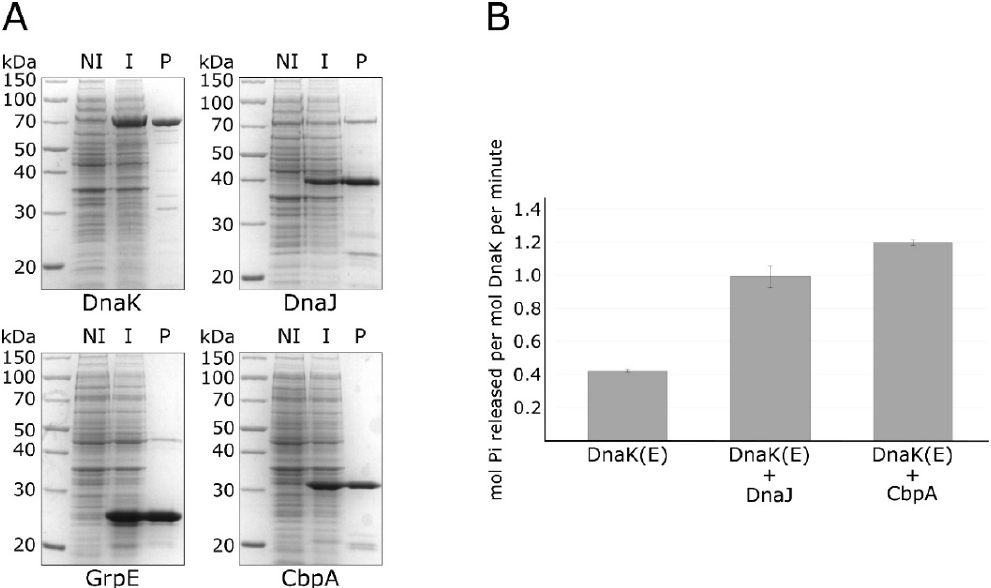
Figure 2. Purification of recombinant chaperone proteins and in vitro ATPase assay. Panel ( A ) sodium dodecyl sulfate–polyacrylamide gel electrophoresis (SDS-PAGE) showing the DnaK, DnaJ, GrpE and CbpA purified proteins (marked underneath each panel) following Ni–NTA affinity chromatography. Symbols: NI, total protein extract of non-induced bacteria; I, total protein extract from induced bacteria; P, purified protein. Panel ( B ) ATPase activity of DnaK measured alone (DnaK (E)), with DnaJ (DnaK (E) + DnaJ) or with CbpA (DnaK (E) + CbpA). Standard error was calculated from 3 independent experiments. The (E) symbol indicates that all the reactions included the nucleotide exchange factor GrpE.